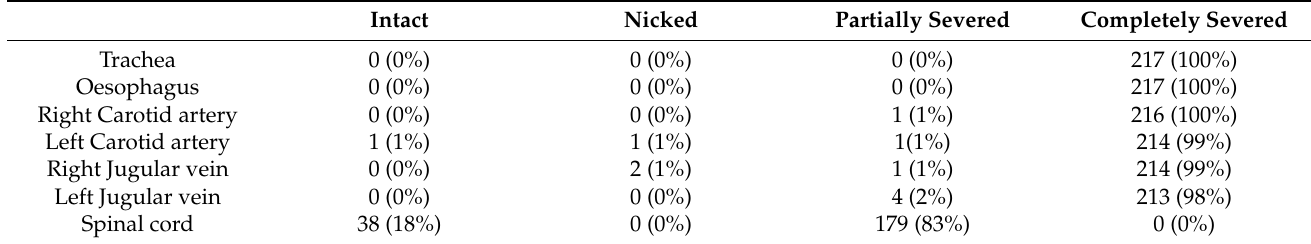
Table 5. Post slaughter cut pathology prior to the scalding tank ( n = 217). Intact Nicked Partially Severed Completely